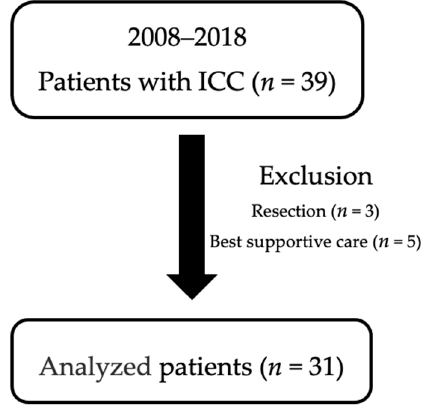
Figure 1. Enrolled